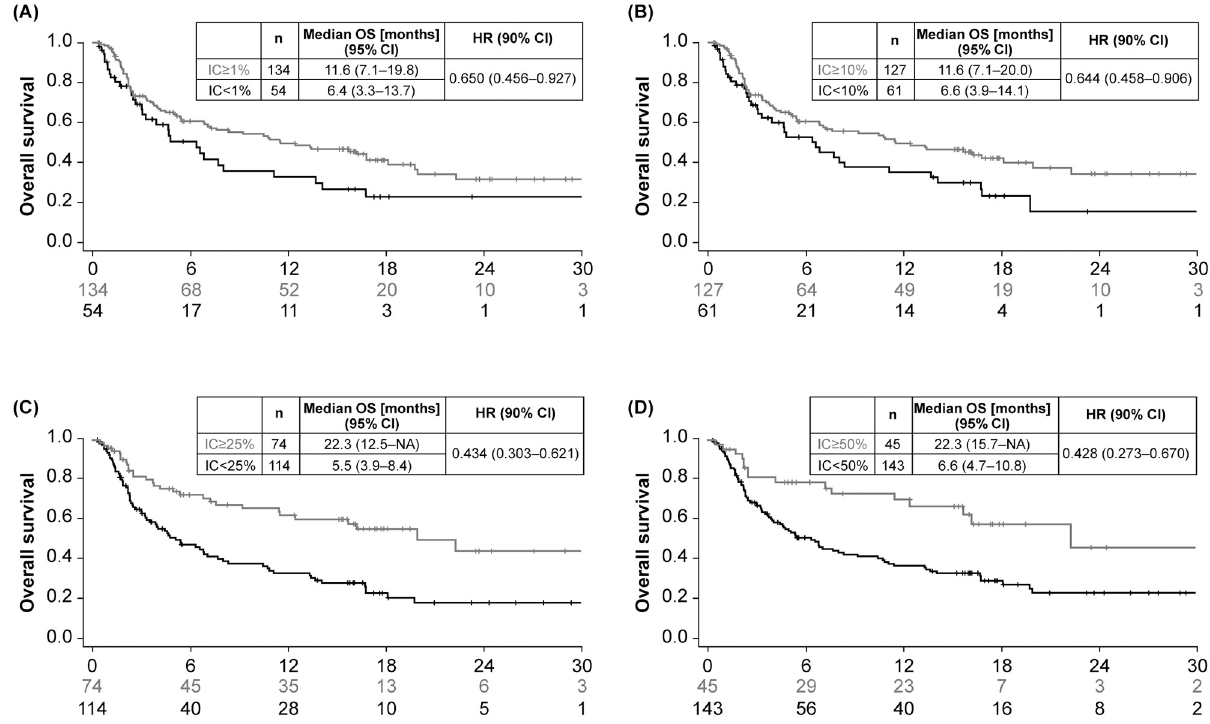
Fig 3. Overall survival in Study 1108 at different cutoffs for PD-L1 expression in tumor-infiltrating immune cells (IC) with cutoffs of � 1% (A), � 10% (B), � 25% (C), and � 50% (D). CI, confidence interval; IC, tumor-infiltrating immune cell; HR, hazard ratio; NA, not applicable; OS, overall survival; PD-L1, programmed death